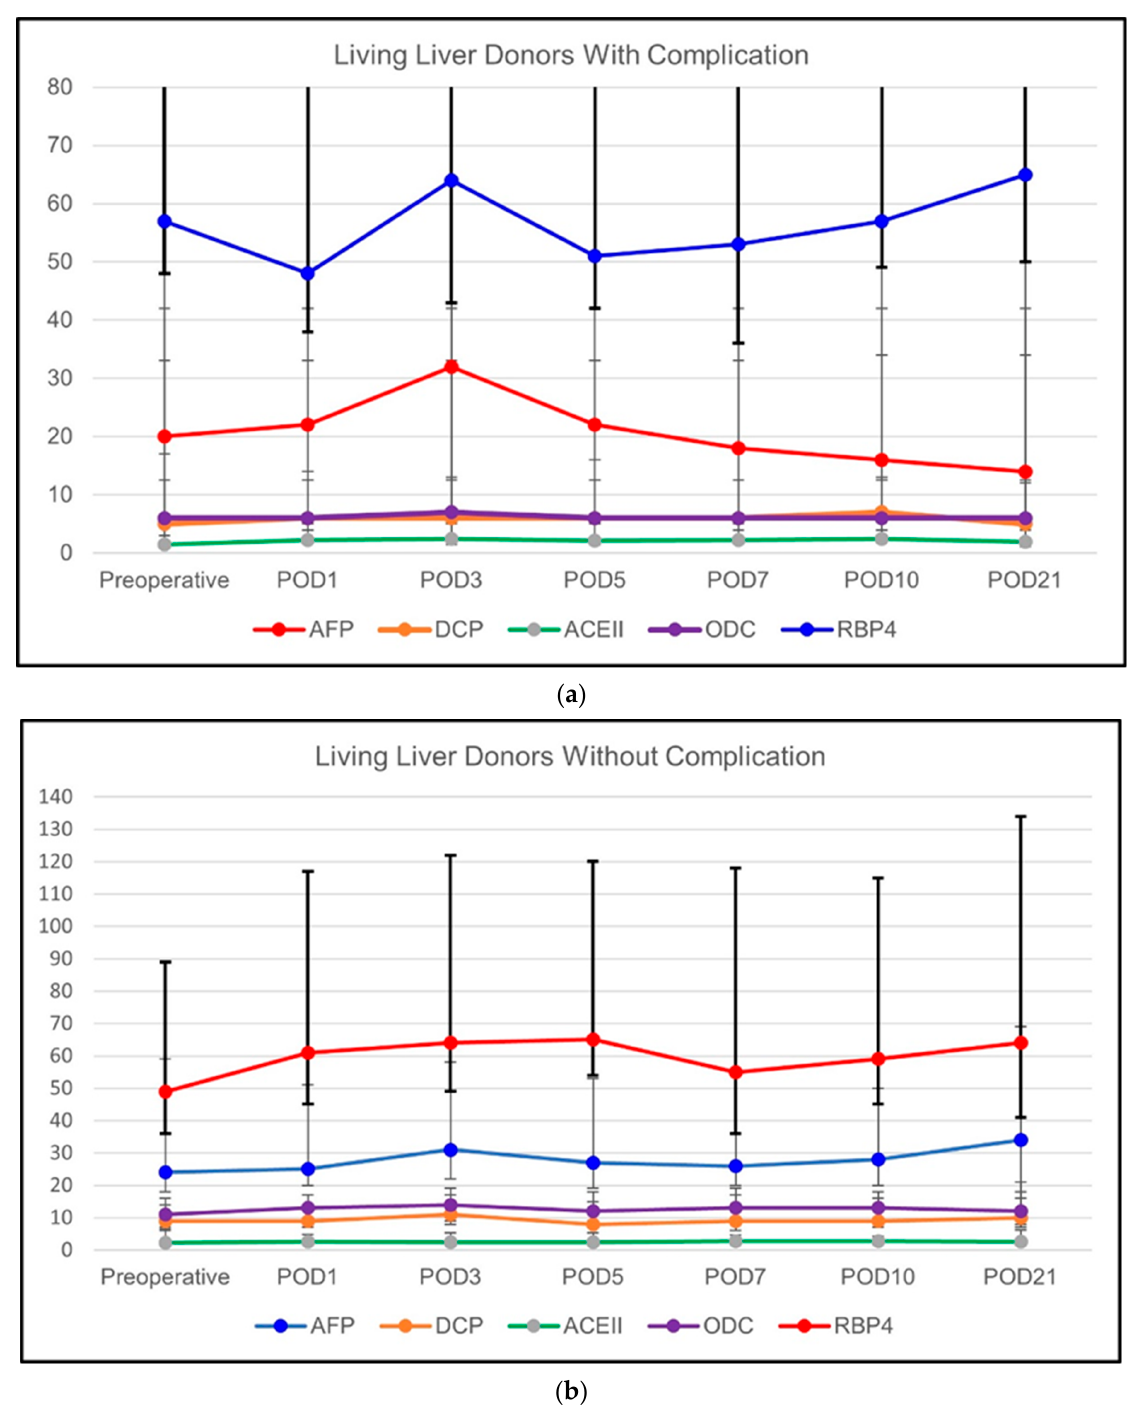
Figure 5. ( a ) The course of regeneration-related biochemical parameters of LLDs with postoperative complications (requiring relaparotomy); and ( b ) the course of regeneration-related biochemical parameters of LLDs without postoperative complications.